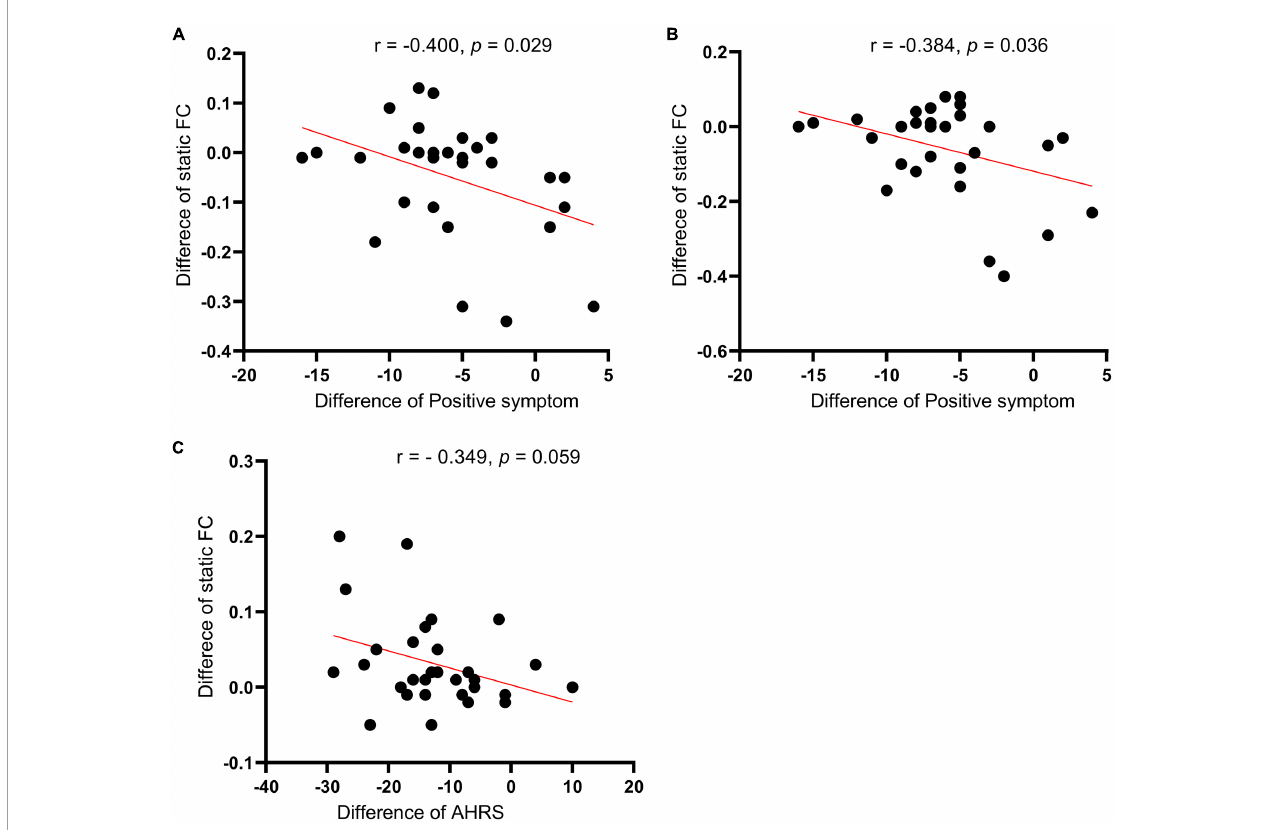
FIGURE5 Correlations of the seed-based (left TPJ) static functional connectivity (SFC) difference values (posttreatment vs. pretreatment) in the left supplementary motor cortex (A) and right putamen (B) with the positive symptom score changes of PNASS in active treatment group. (C) Correlations of the seed-based SFC difference values (posttreatment vs. pretreatment) in the right inferior temporal gyrus with AVH score changes in active treatment group. TPJ, left temporoparietal junction; PANSS, positive and negative symptom scale; AHRS, auditory hallucination rating